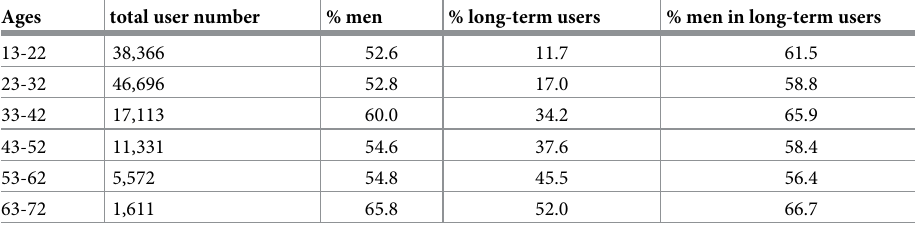
Table 2. Description of long-term users characteristics.